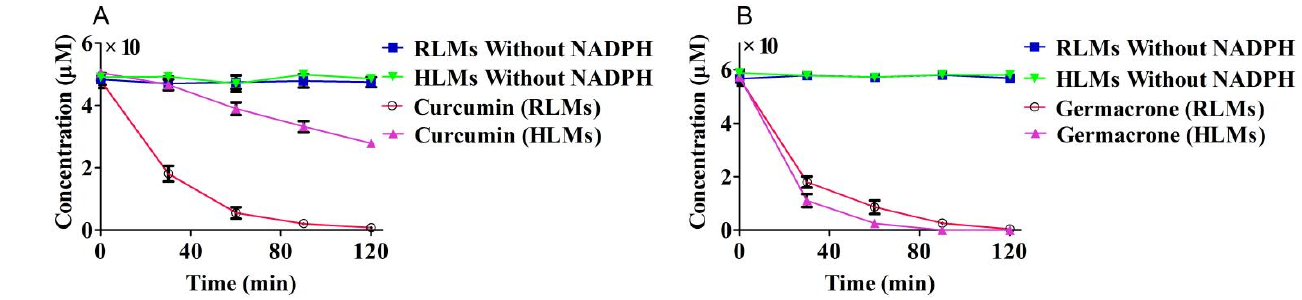
Figure 3. Degradation of curcumin ( A ), 50 μM and germacrone ( B ), 60 μM in RLMs and HLMs ( n = 3).